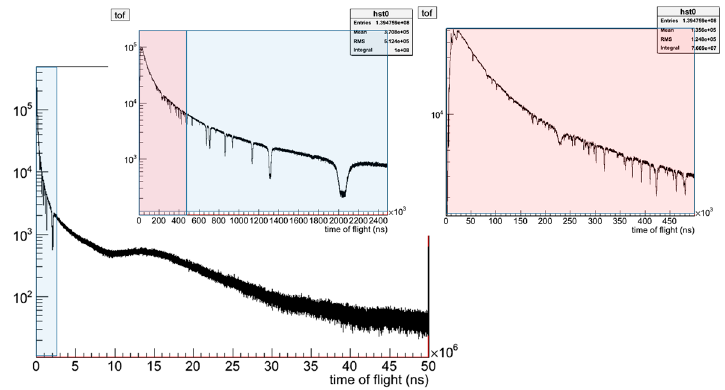
Figure 6. Sample data collected with the 55 photomultiplier tube liquid scintillator detector at the 60 m station of flight-path 5. The large chart shows the entire 50 ms neutron pulse of the 20 Hz LANSCE Target 1. The area marked in blue is shown magnified in the left inset and the data shown in red in the left inset are displayed magnified in the right inset to illustrate the high energy resolution and large energy range available with this detector. Complementary imaging and tomography results are obtained from the MCP detector, with chemical characterization using neutron absorption resonances at higher energies obtained from the liquid scintillator detector.